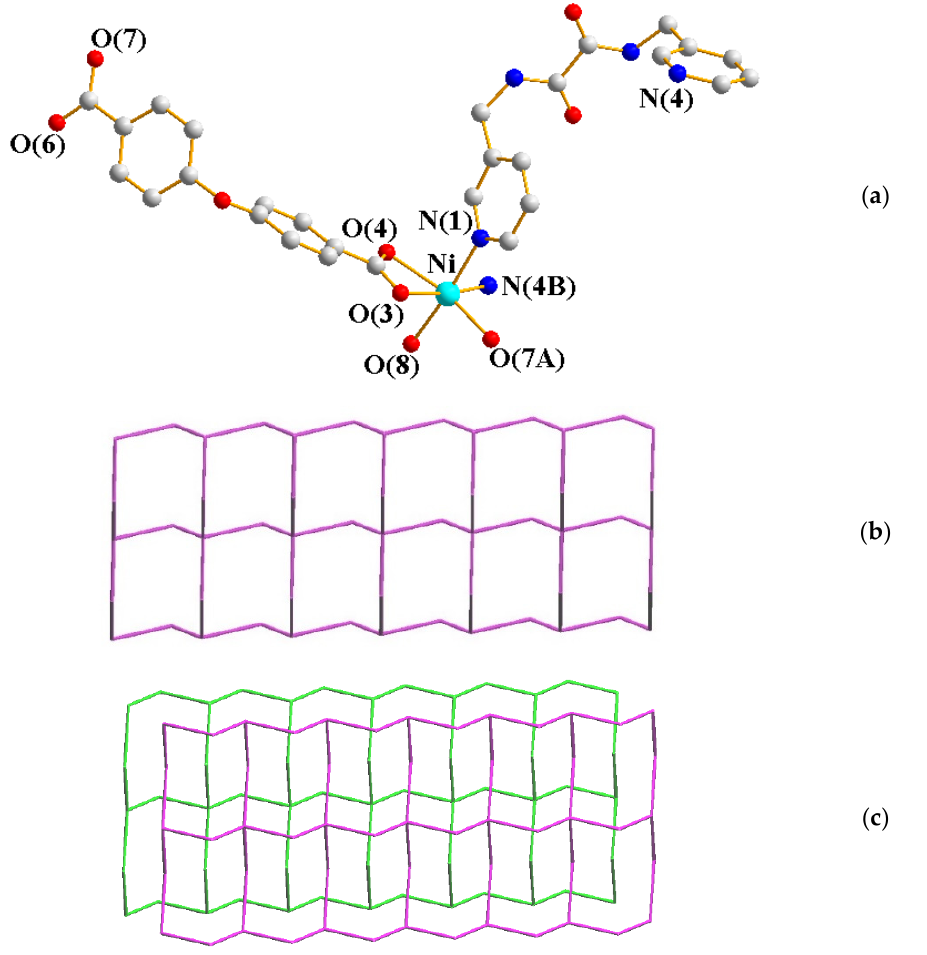
Figure 2. ( a ) Coordination environment of Ni(II) ion in 1 . Symmetry transformations used to generate equivalent atoms: (A) x, y + 1, z − 1; (B) x − 1, y, z. ( b ) A drawing showing the 2,4L2 topology. ( c ) A drawing showing the interdigitation.